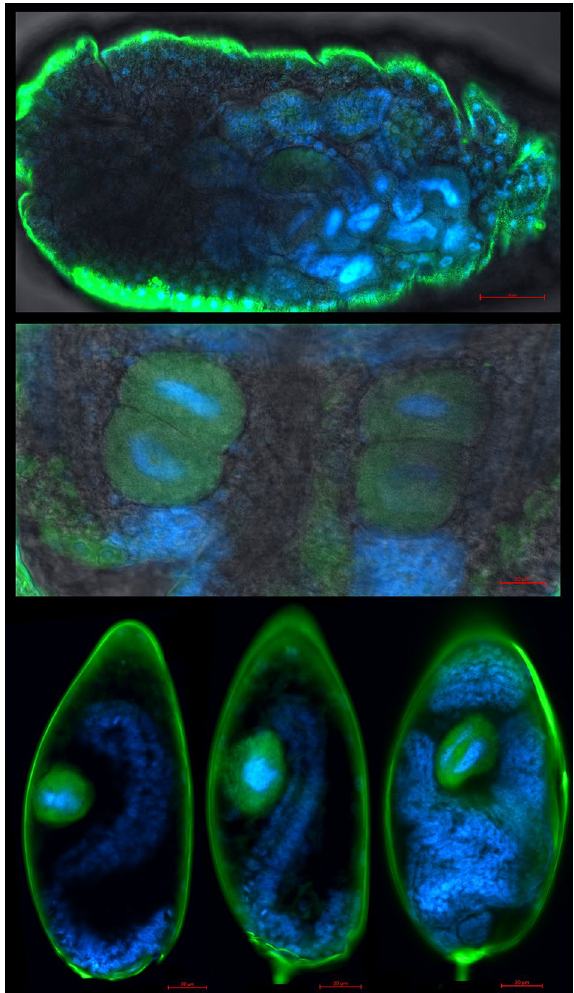
Figure 2. Localization of Arsenophonus (green) in whitefly adults (top), nymphs (middle), and eggs (bottom three) using fluorescence in situ hybridization with DAPI nucleic acid counterstain (blue). Note the strong false signal around the edges of the samples caused by the refraction of laser light when passing through the cuticle. This artefact is especially pronounced here due to high laser power and gain that were required to detect low densities of Arsenphonus. The background grayscale image shows the transmitted light acquired using the transmitted photomultiplier tube (tPMT)